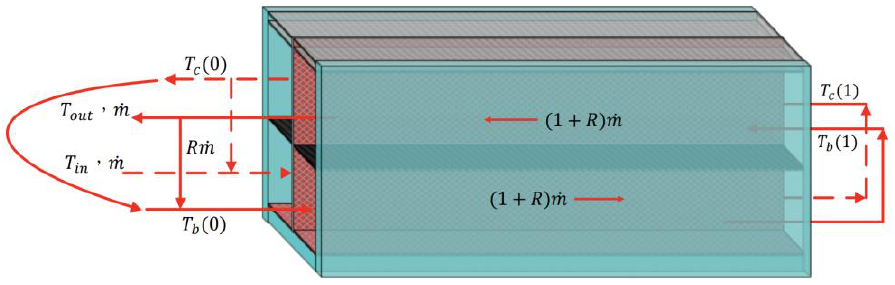
Figure 6. Schematic diagram of a recycling multi-pass solar air collector (Type C).